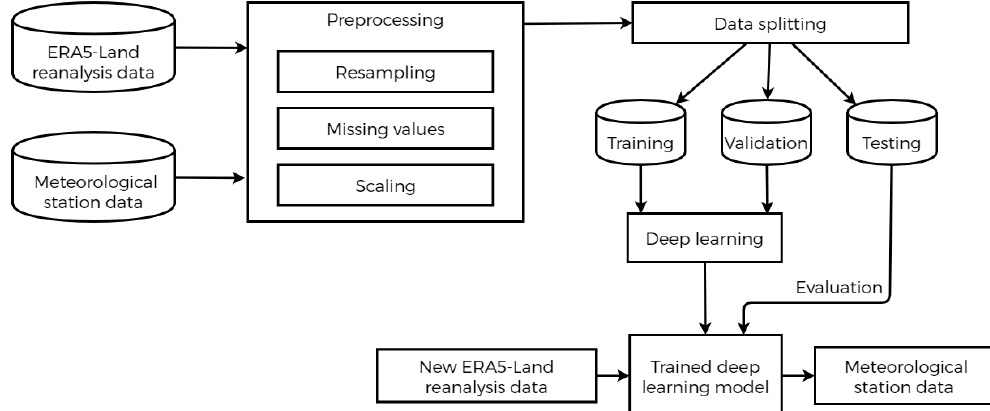
Figure 5. The flowchart of the deep learning approach.